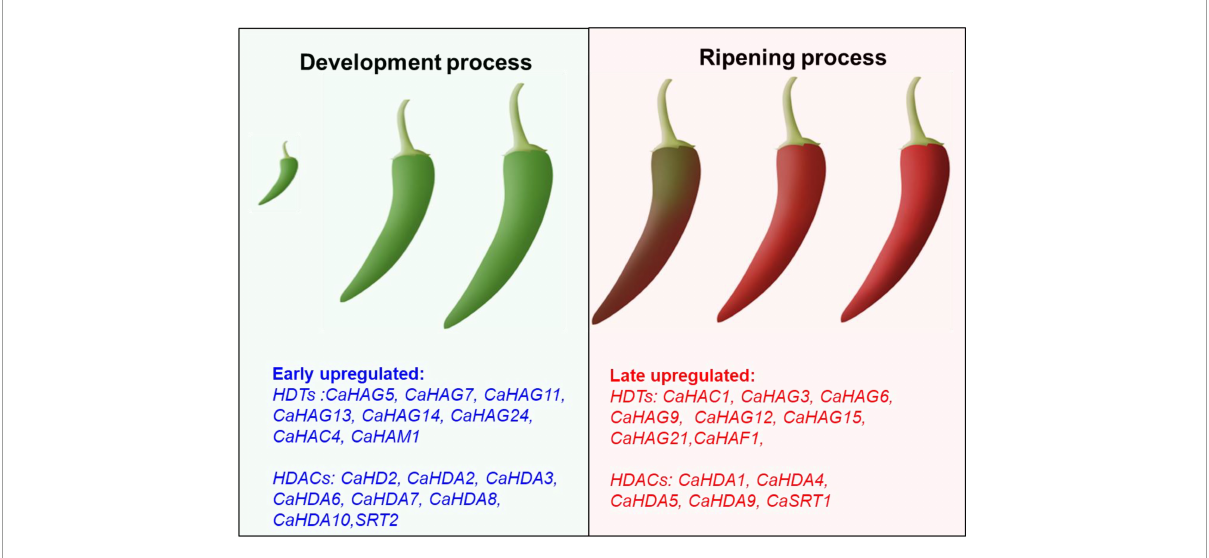
FIGURE9 Proposal model of CaHDTs and CaHDACs candidates in pepper development and ripening. The leaf panel display early upregulated histone acetylation modifiers might be associated with the fruit development-related process. The right panel display late upregulated histone acetylation modifiers might be related to the fruit ripening-related